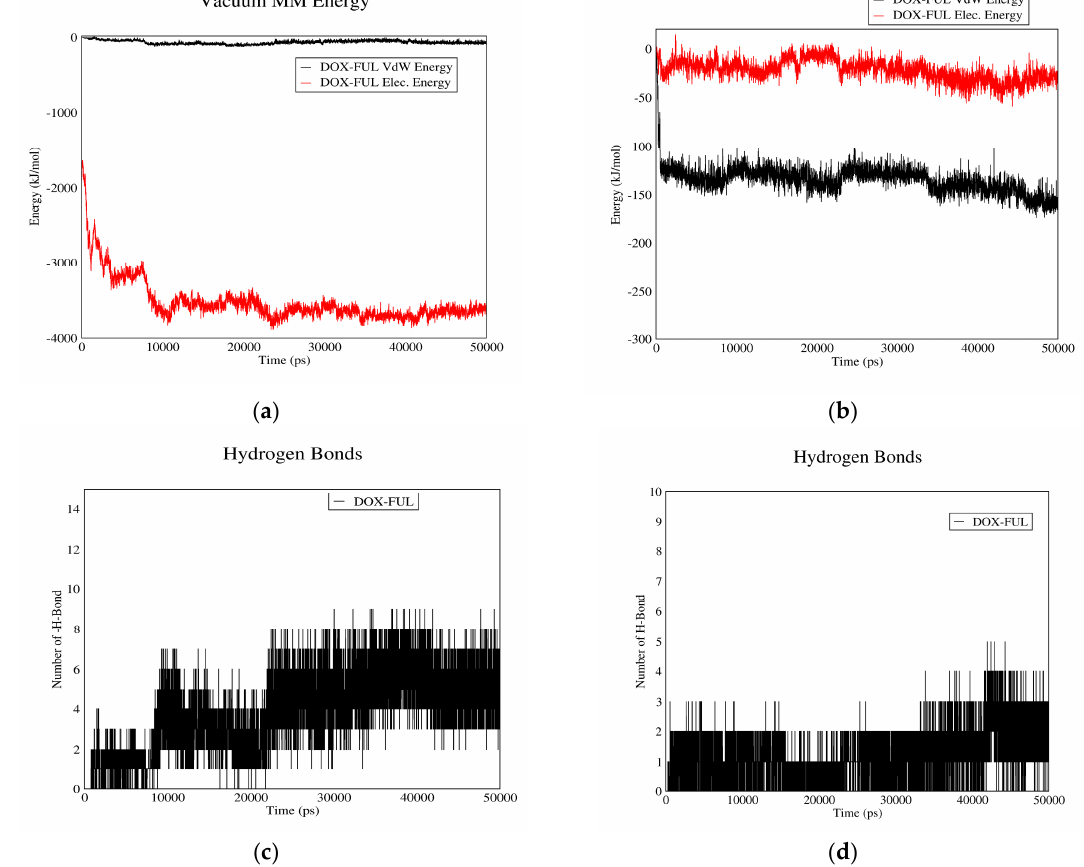
Figure 2. DOX–Fullerene interaction energies and hydrogen bonds: ( a ) electrostatic and Van der Waals energies of DOX–Fullerene interaction versus time in neutral pH; ( b ) electrostatic and Van der Waals energies of DOX–Fullerene interaction versus time in acidic pH; ( c ) the number of hydrogen bonds between DOX and fullerene versus time in neutral pH; ( d ) the number of hydrogen bonds between DOX and fullerene versus time in acidic pH.